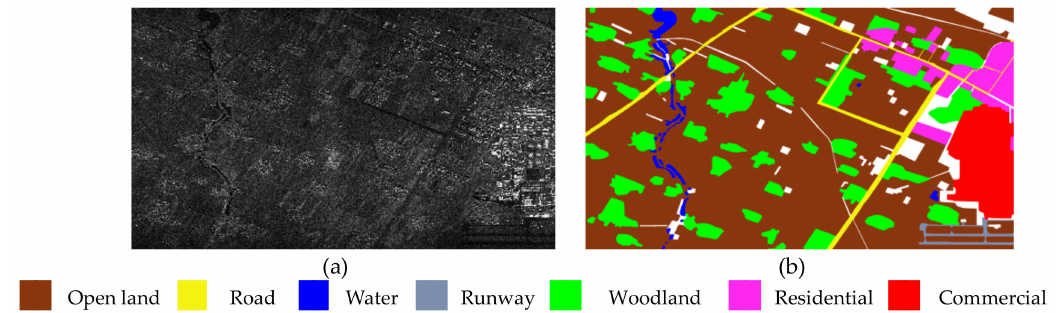
Figure 7. Chinese Airborne SAR image. ( a ) Original SAR image. ( b ) Ground-truth. F-SAR data: The fourth HR SAR image was acquired in Bavaria, Germany (https: //www.dlr.de) with a VV-polar imaging mode. The data source is provided by an X-band F-SAR sensor of the German Aerospace Center. The image size is 6187 × 4278, with a spatial resolution of 0.67 m. The original image and the ground-truth are shown in Figure 8a,b. Four typical categories are included: Water, residential, vegetation, and open